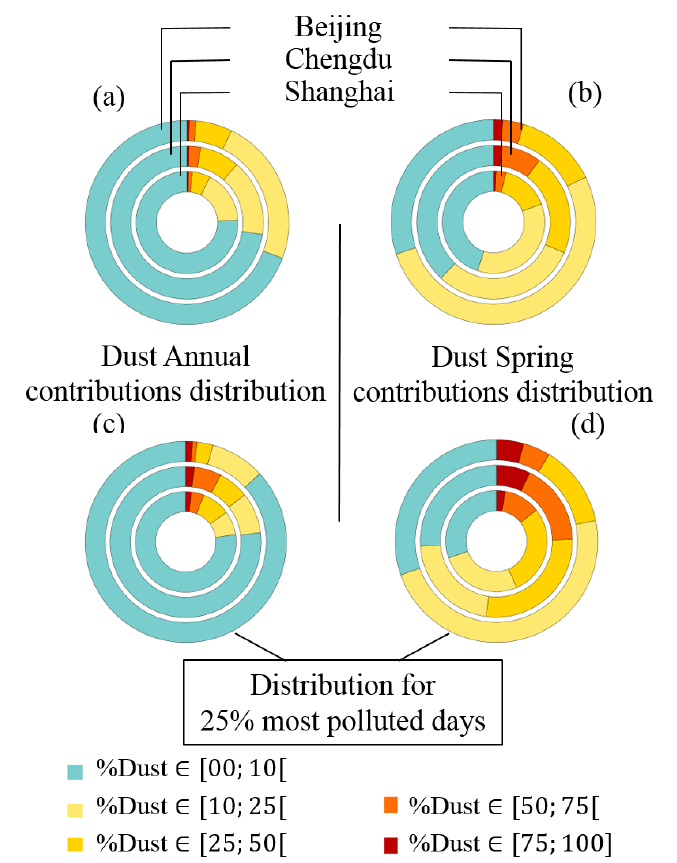
Figure 7. ( a ) Percentage of days when dust contributes between 0–10%, 10–25%, 25–50%, 50–75% and 75–100% to daily PM 10 averages; ( b ) same as ( a ), but for spring only; ( c ) Same as ( a ), but for the 25% of most polluted days only (in terms of PM 10 level); ( d ) Same as for ( c ), but for spring